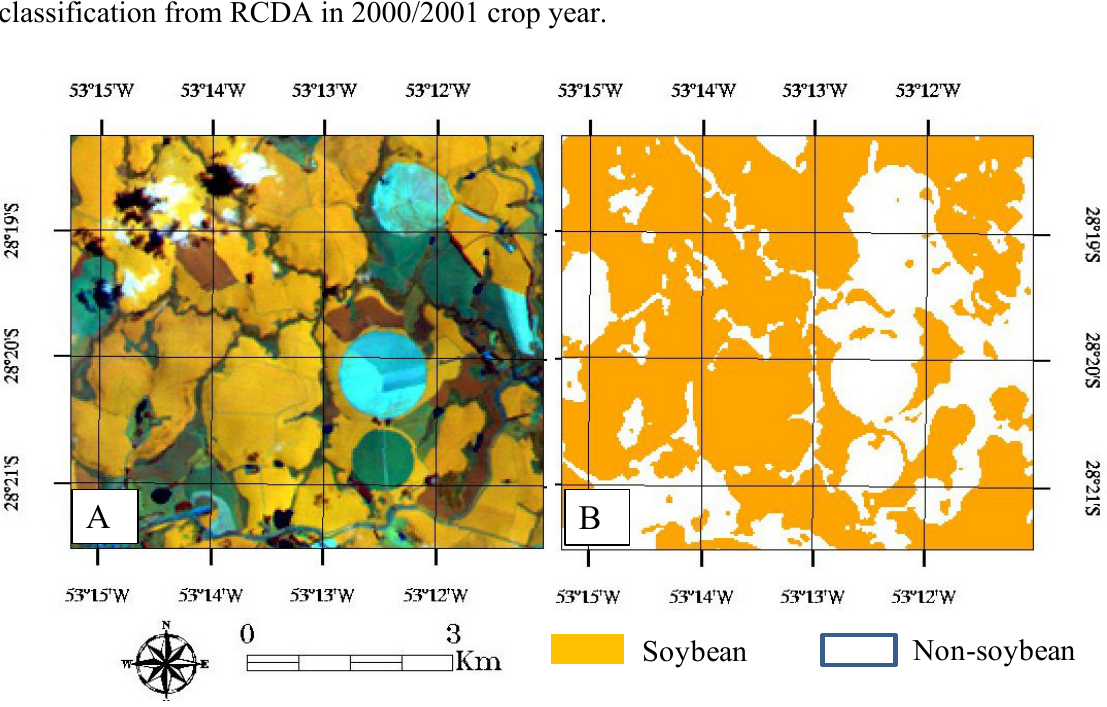
Figure 3. Sector enlargement in Rio Grande do Sul State, for comparison between: ( A ) Landsat-5TM, (RGB/453) in 25 February 2001; and ( B ) resulting soybean map classification from RCDA in 2000/2001 crop